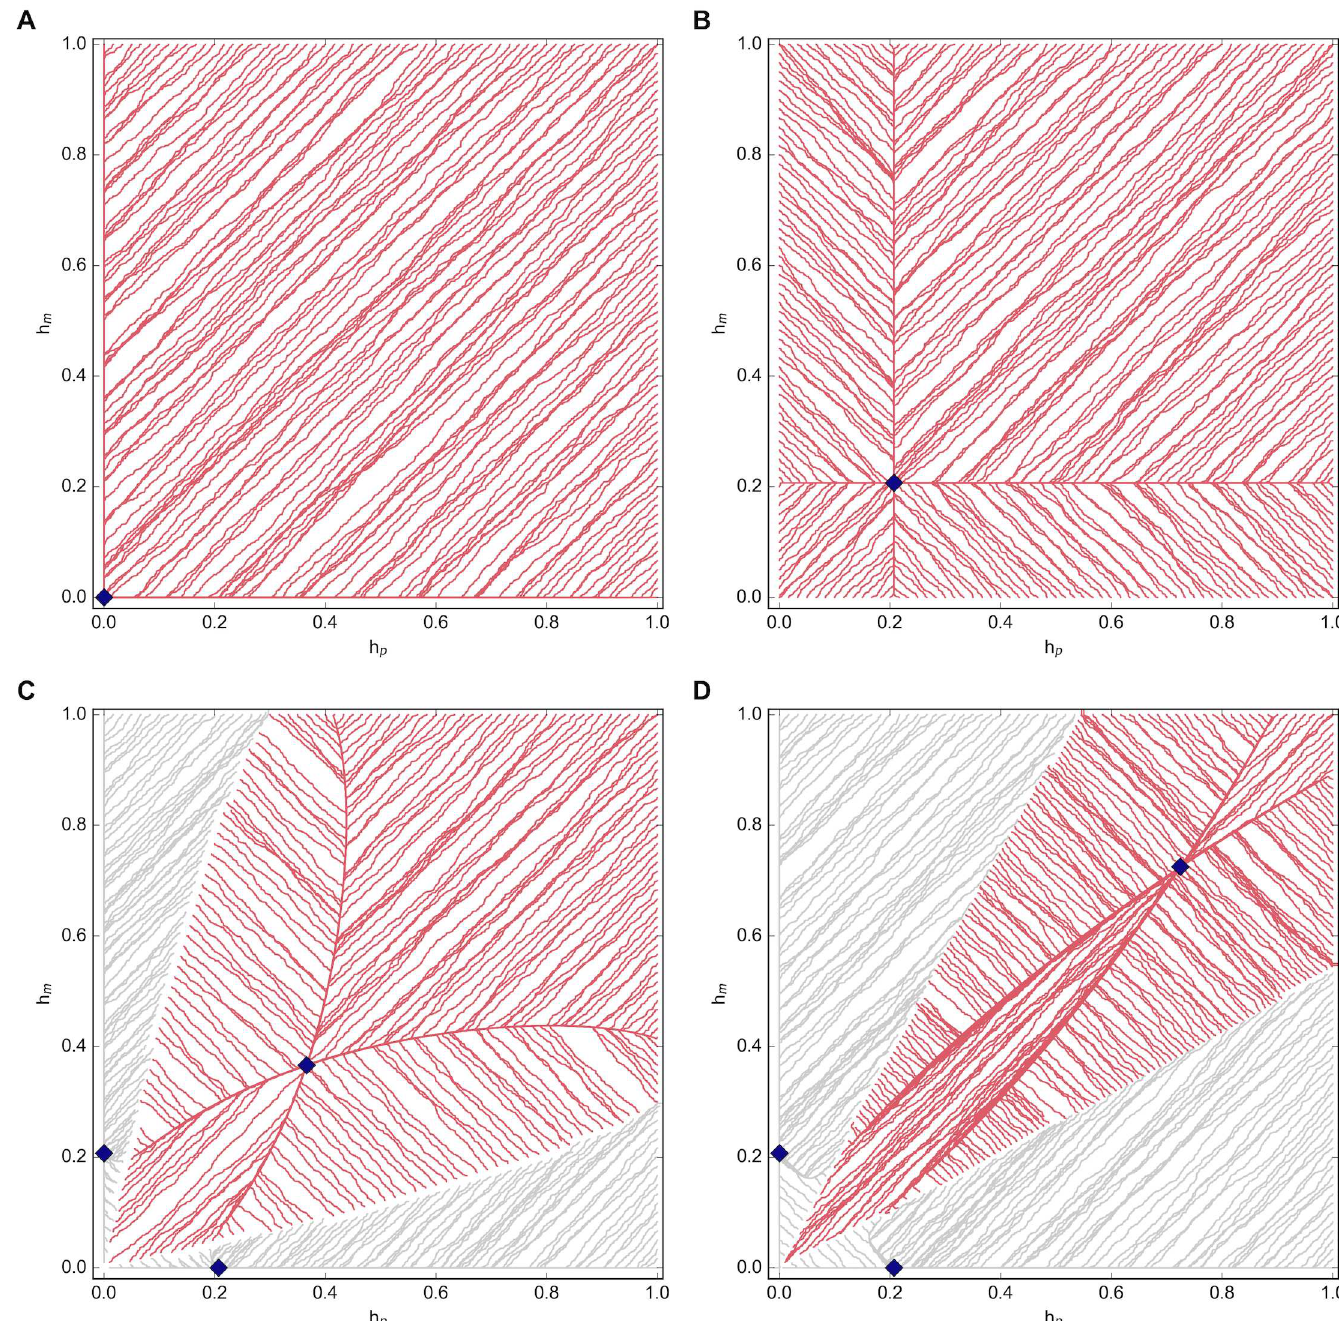
Fig 2. Equilibrium help trajectories with fixed proportions. (a) z = 0; (b) z = 1; (c) z = 2; (d) z = 5 when S m = S p = 0.5. The initial choice of h m and h p dictates the direction of evolution(as shown by the red and grey lines) towards the resulting observed equilibria(denoted by ^ ). In particular, the basins of attraction for each equilibriumcan be seen, with the red lines corresponding to the competitive helpingequilibrium and the grey lines corresponding to one type providing no help.